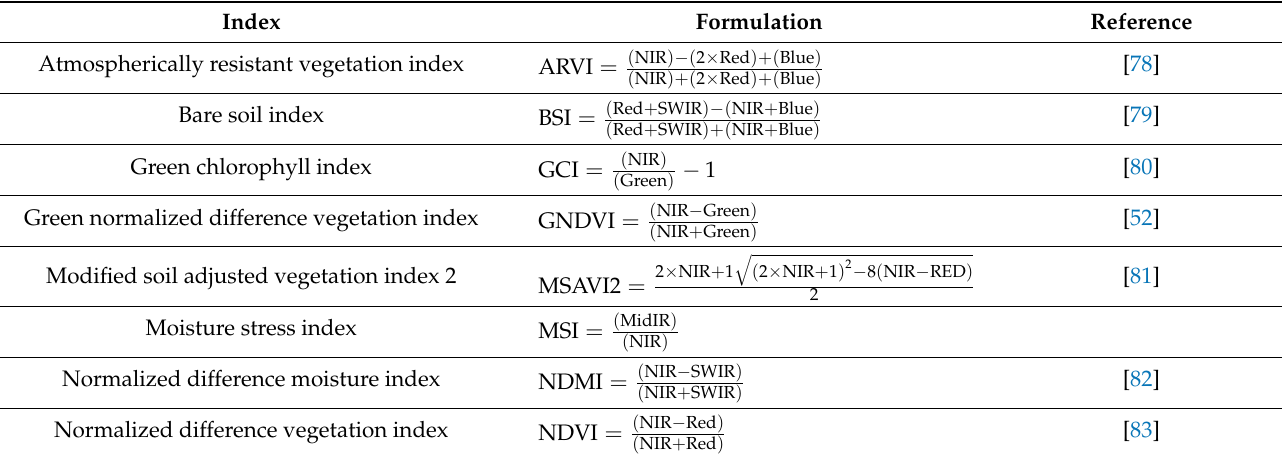
Figure 3. ( a ) NDVI values and locations of the grazing hotspots under all the stocking densities during the summer (December to February) of 2017/2018, ( b ) during autumn (March to May) of 2018, and ( c ) during winter (June to August) of 2018. Table 1. Spectral indices generated for each Sentinel-2 A